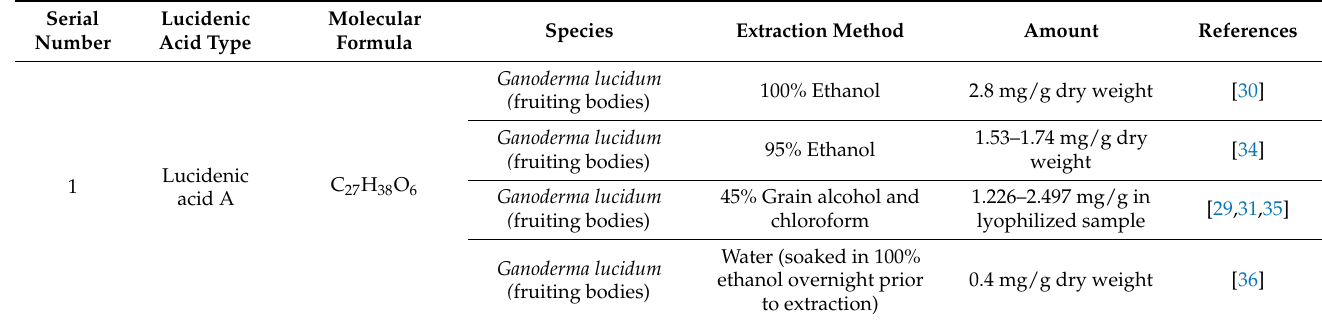
Table 1. The sources, molecule formulae, and amounts of lucidenic